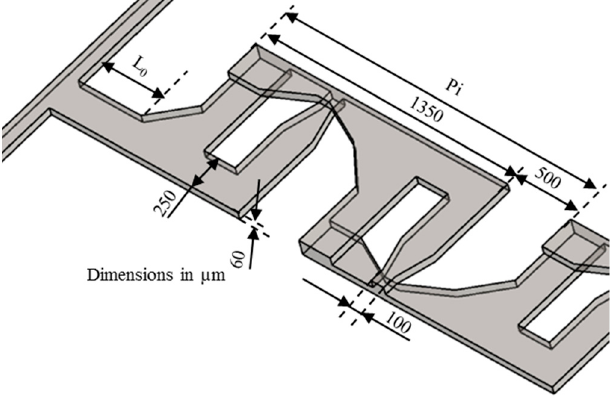
Figure 7. Improved serpentine lamination micromixer: M ‐ 7 (no. of mixing units used: 2) [81].